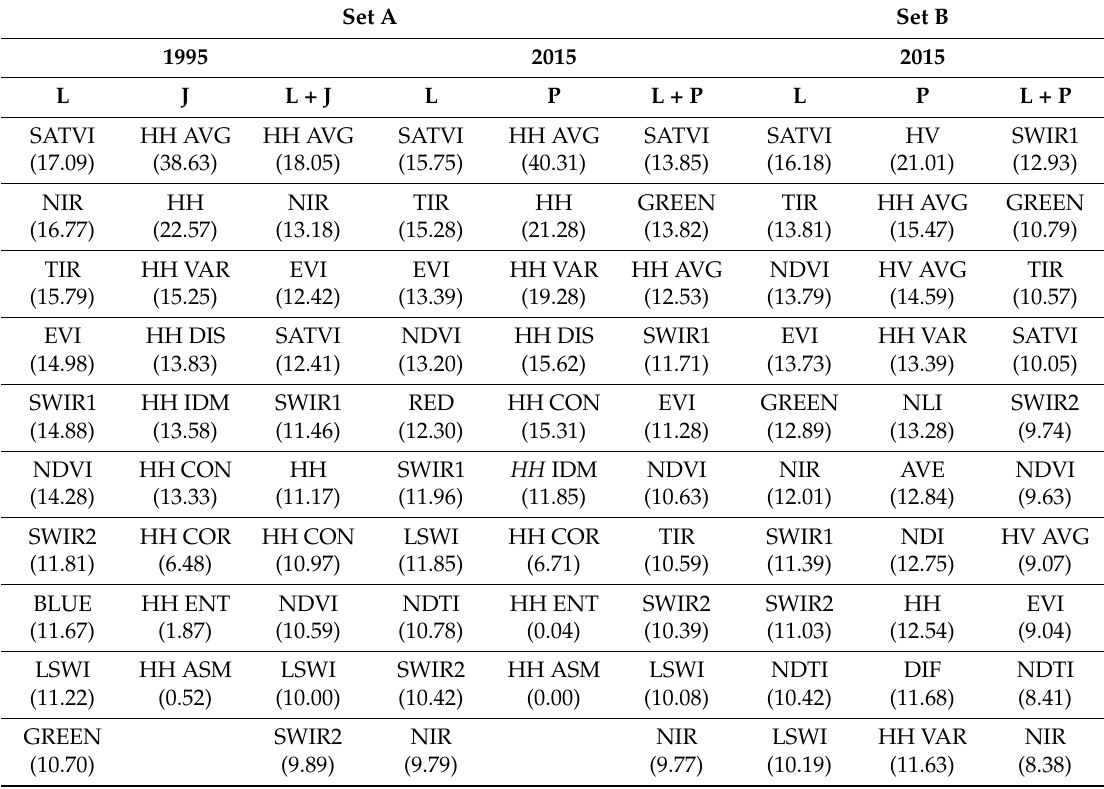
Table 6. Ten most important predictor variables from the classification results of Landsat-only (L), SAR-only (J or P), and Landsat + SAR (L + J or L + P) data. Numbers in parentheses below each variable indicate variable importance scores based on mean decrease in accuracy (permutation importance).